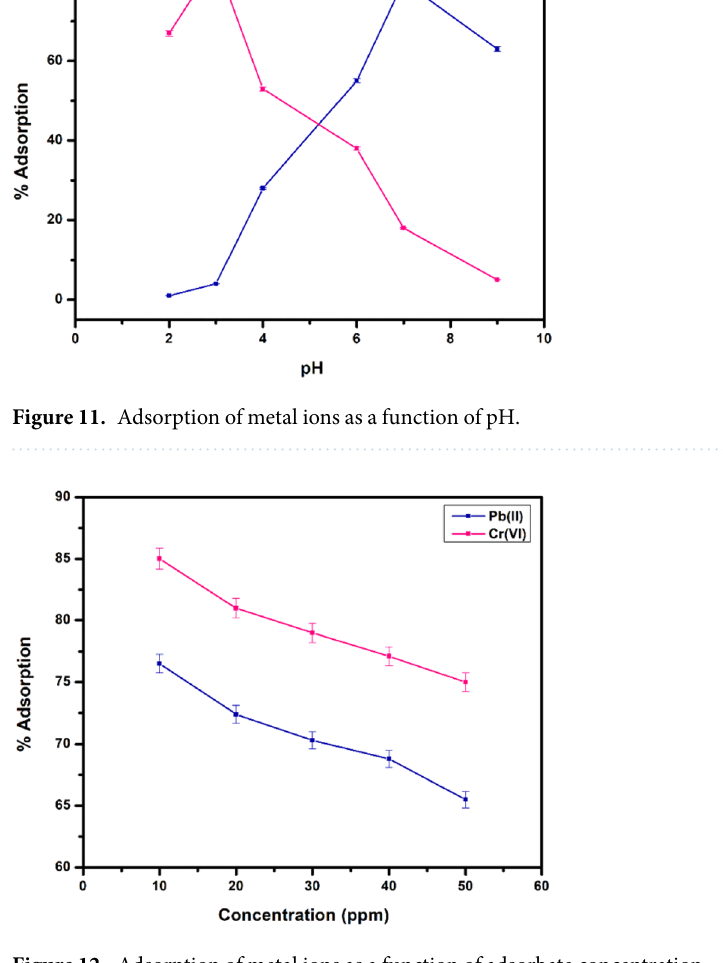
Figure 12. Adsorption of metal ions as a function of adsorbate